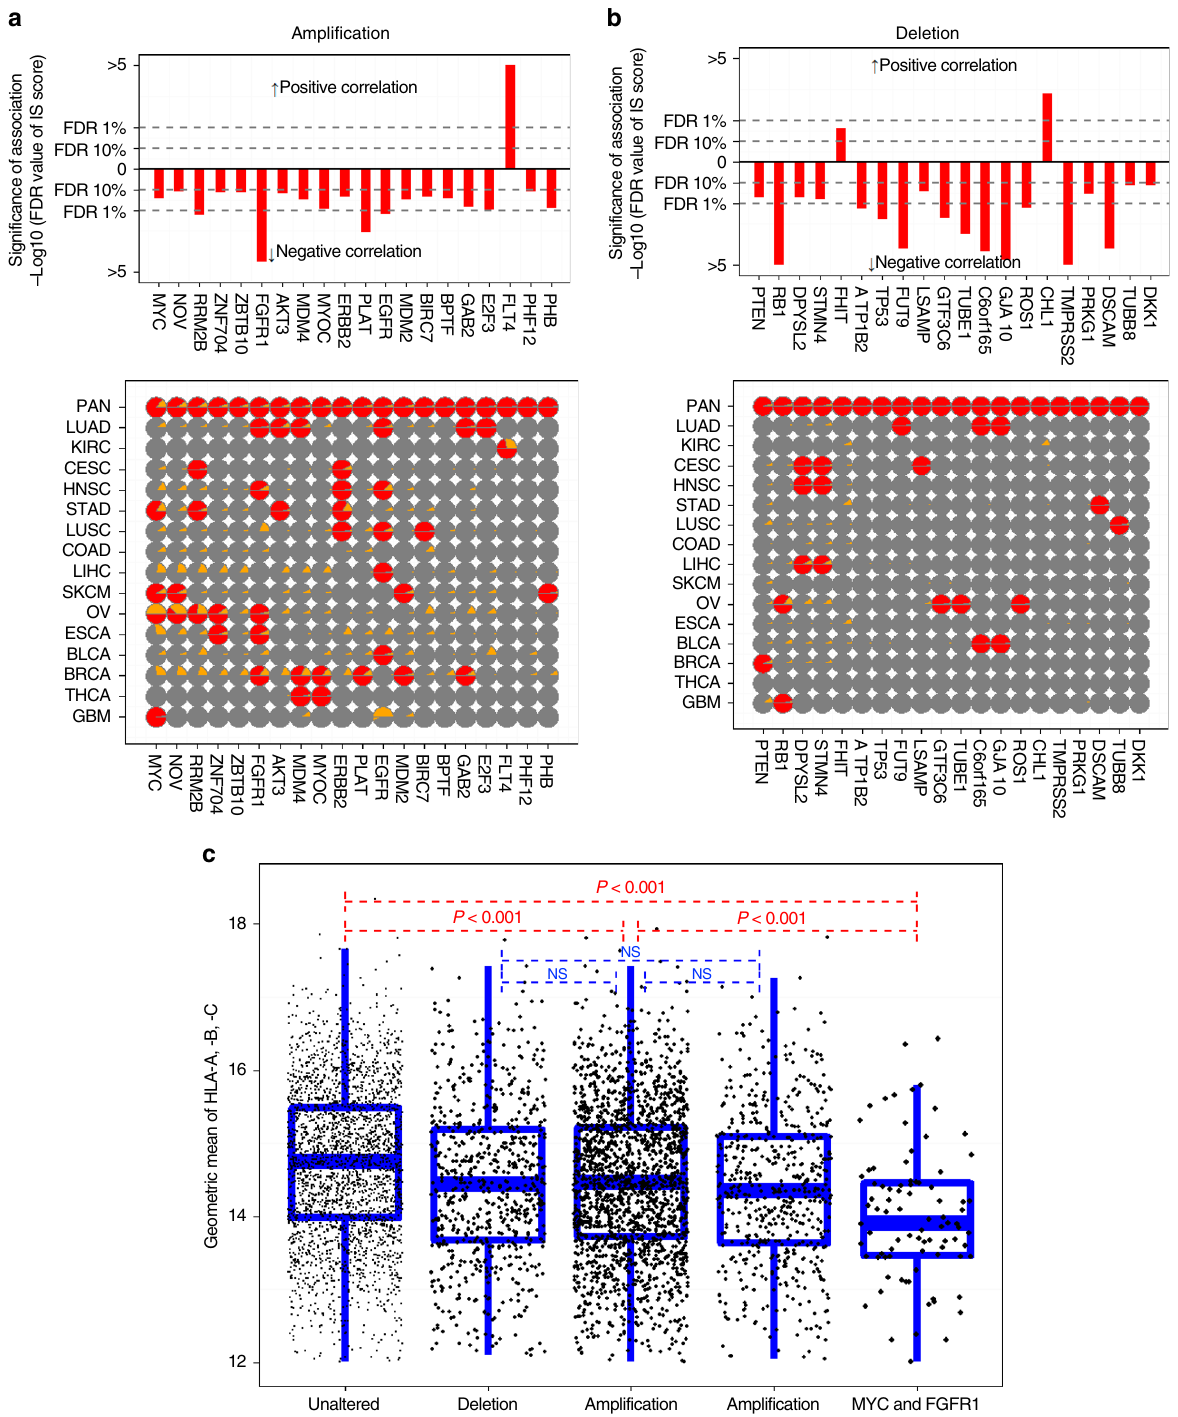
Fig. 7 Somatic copy number alterations associated with immune signature scores. a , b Top: the signi fi cant pan-cancer-wide association of ampli fi ed a and deleted b genes with immune signature (IS) scores. Red bars represent signi fi cance (FDR) of association of ampli fi cation with IS scores in each gene. Bottom: The signi fi cance of association in each cancer type. Red or gray indicate signi fi cance or insigni fi cance, respectively, and yellow indicates the frequency of ampli fi cation in each gene. c Mean expression of HLA-A, HLA-B, and HLA-C in not signi fi cantly altered, deleted only, ampli fi ed only, both ampli fi ed and deleted, and MYC and FGFR1 co-ampli fi ed tissues. Blue lines in the box represent upper 75%, median, and lower 25% values of subtype. See also Supplementary Fig. 29 and Supplementary Data 6,